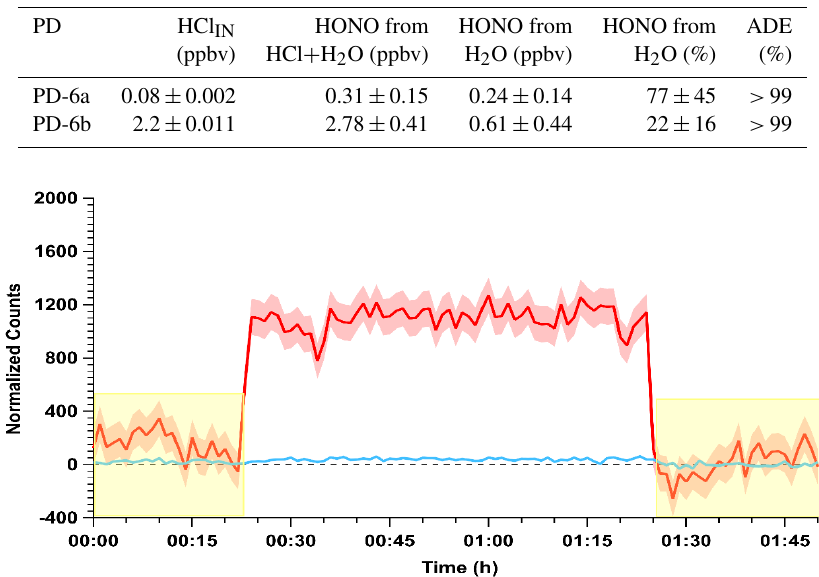
Table 2. Mass balance of measured mixing ratios of HCl entering and HONO exiting the calibration source to determine acid displacement efficiency (ADE) at 50% RH and 40 ◦ C. Uncertainties represent 1 σ standard deviation from the mean for ≥ 30min of measurements and 1 σ propagated error for calculated values.